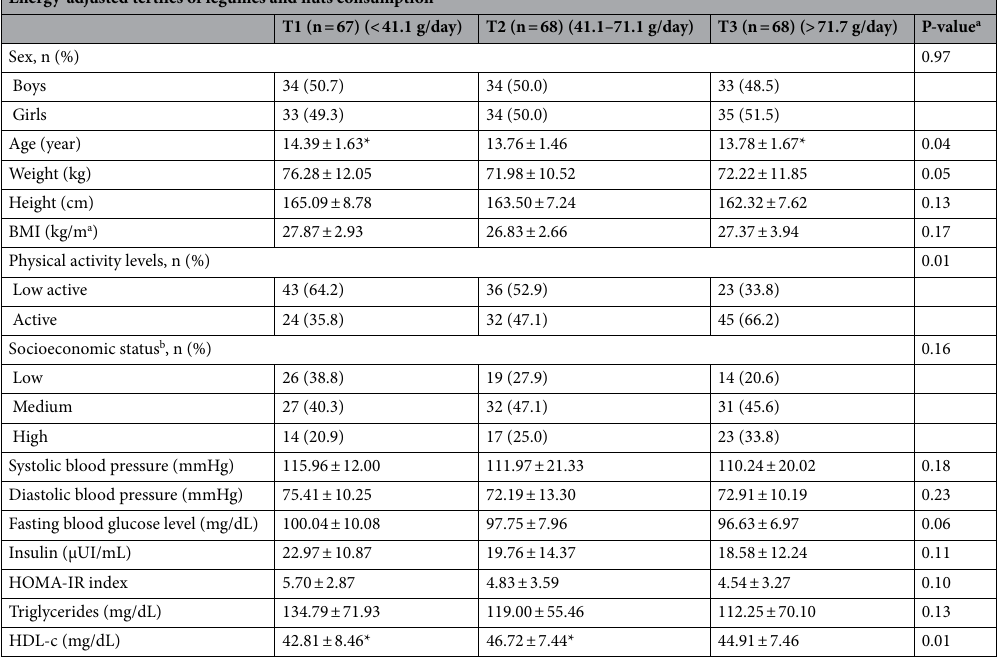
Table 1. General characteristics and cardiometabolic factors of study participants across energy-adjusted tertiles of legumes and nuts consumption. Values are mean ± SD; unless indicated. BMI body mass index, HOMA homeostasis model assessment insulin resistance, HDL-c high-density lipoprotein cholesterol. *P-values < 0.05 from post hoc analysis (Bonferroni). a P-value obtained from one way ANOVA and χ 2 test for quantitative and categorical variables, respectively. b Socioeconomic status (SES) score was evaluated based on parental education level, parental job, family size, having car in the family, having computer/laptop, having personal room and having travel by using a validated